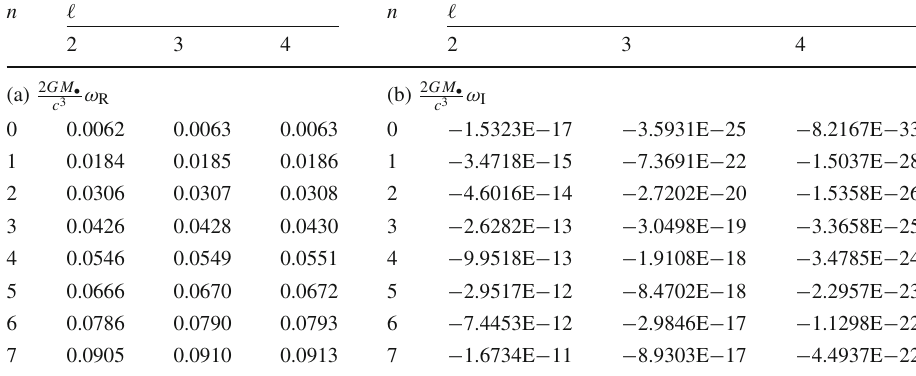
Table 1 The real (left panel) and imaginary (right panel) frequency of the quasinormal modes of a cosmological black hole M • = 10 M (cid:2) . These frequencies apply to the solution = 8 of the case A ( ± ) 3 { K = 1 , N = 3 } . Differences between different solutions are minor, as depicted in Fig. 4 for n =